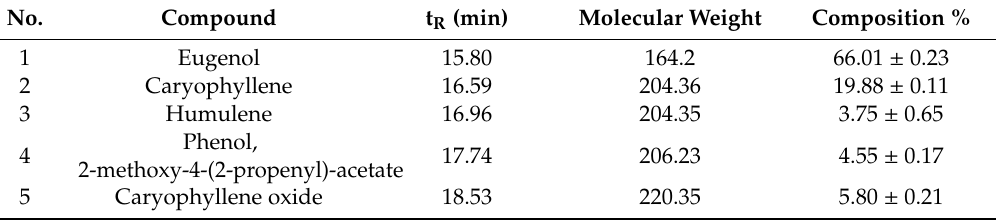
Figure 1. A typical gas chromatogram of the constituents of CEO. Table 1. Percentage composition of volatile constituents of clove essential oils